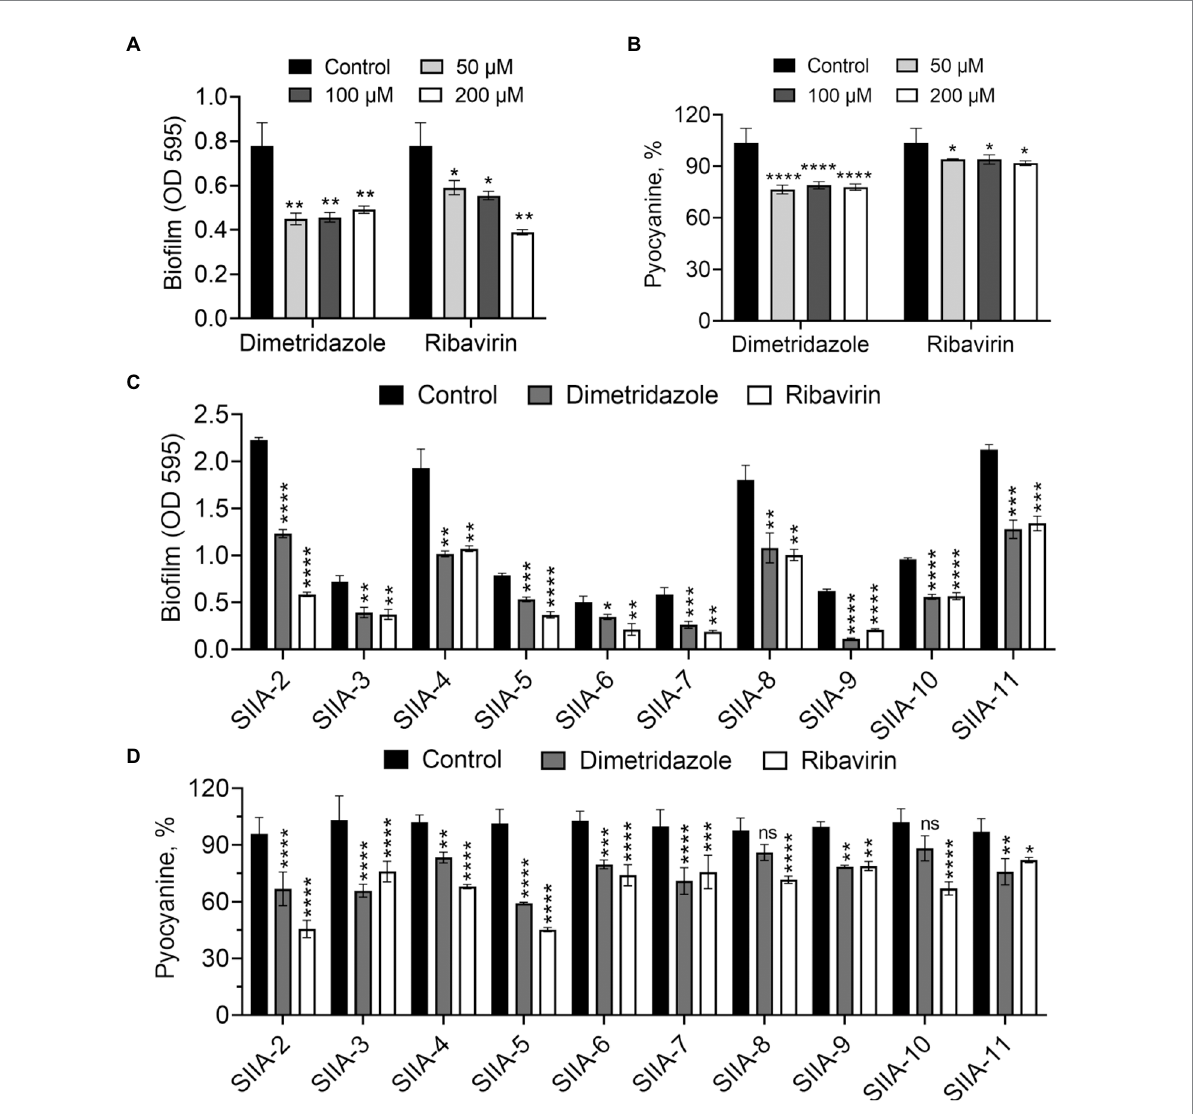
FIGURE 3 Effects of Dimetridazole and Ribavirin on biofilm and pyocyanine production of Pseudomonas aeruginosa . (A,B) Effects of different concentrations of Dimetridazole and Ribavirin on the production of biofilm and pyocyanin in P. aeruginosa PAO1. (C,D) Effects of Dimetridazole and Ribavirin (200 μ M) on biofilm and pyocyanine production of P. aeruginosa clinical isolates. Data shown are means ± SD of three independent experiments. One-way ANOVA test compared to the control, * p < 0.05, ** p < 0.01, *** p < 0.001, **** p < 0.0001. ns, not